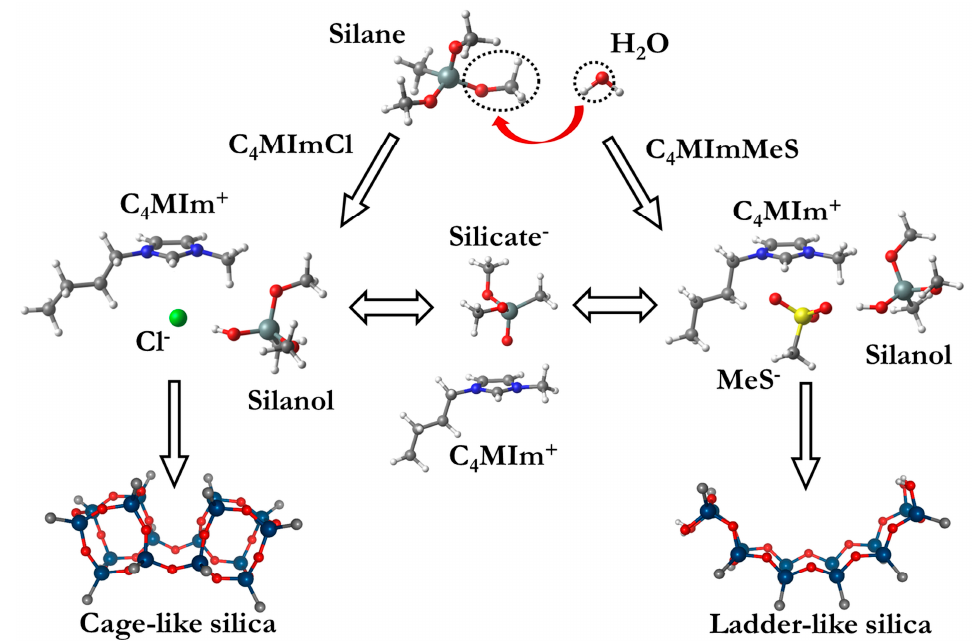
Figure 8. Theoretical structures and evolution of Silica-IL precursors when [C 4 MIm][Cl]